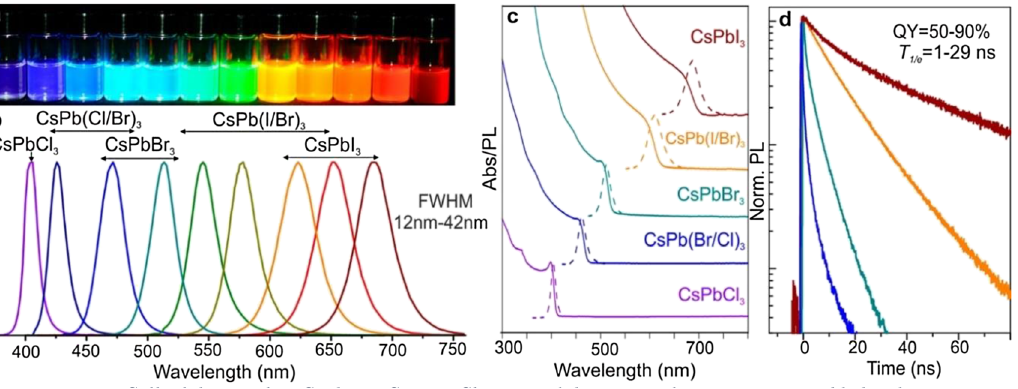
Figure 7: Colloidal perovskite CsPbX 3 NCs (X = Cl, Br, I) exhibit size- and composition-tunable bandgap energies covering the entire visible spectral region with narrow and bright emission: (a) colloidal solutions in toluene under UV lamp ( λ = 365 nm); (b) representative PL spectra ( λ ex =400nmforallbut350nmforCsPbCl 3 samples);(c)typicalopticalabsorptionandPLspectra;(d)time-resolvedPLdecaysforallsamples shown in (c) except CsPbCl 3